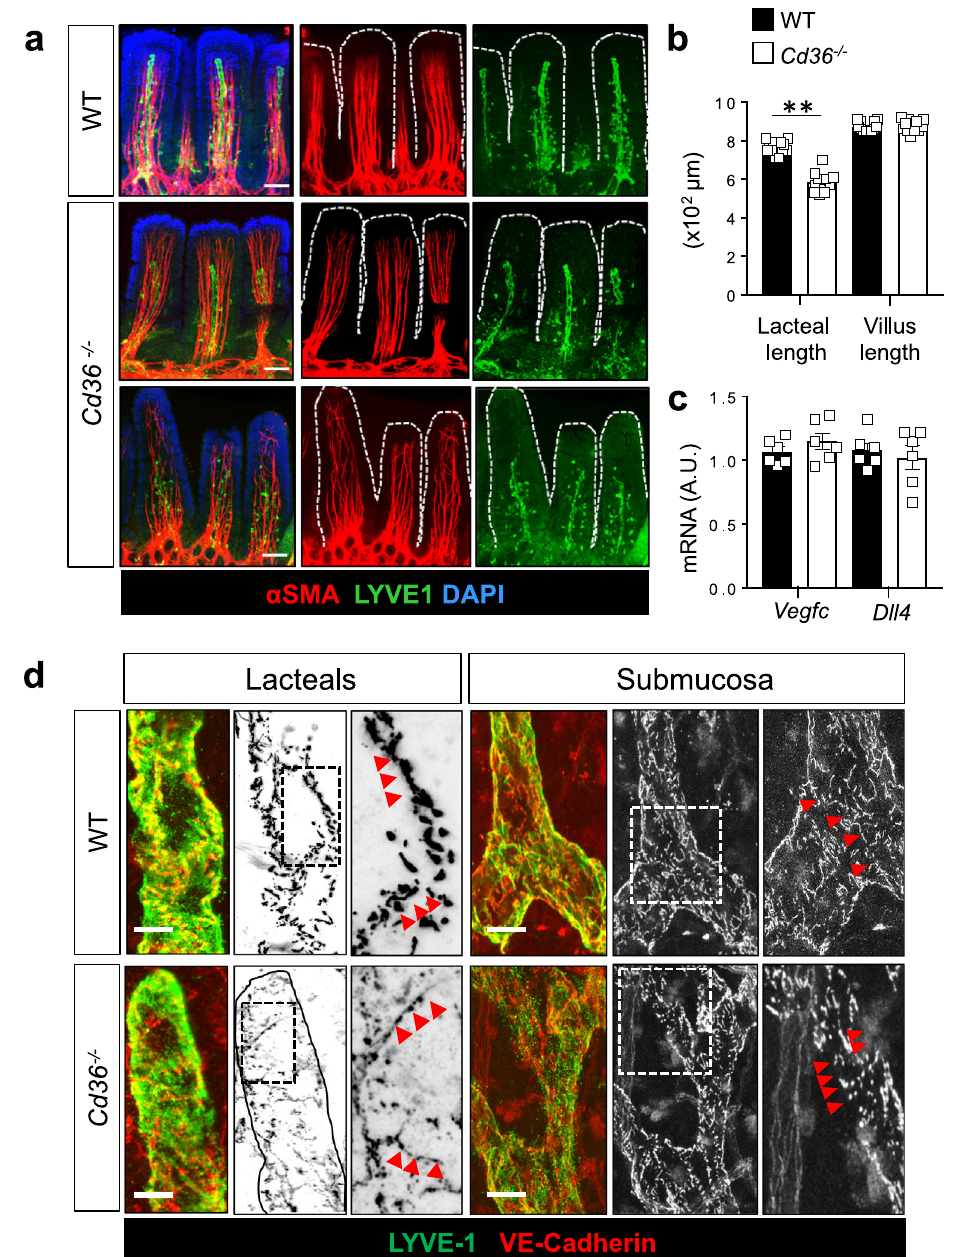
Fig. 2 Cd36 − / − mice have shorter lacteals and disorganized VE-cadherin junctions. a Representative whole-mount staining for lymphatic vessel endothelial hyaluronan receptor 1, LYVE-1, and smooth muscle actin-alpha, α SMA, showing lacteals in jejunum of wild-type (WT) and Cd36 − / − mice. Images were acquired using a Zeiss LSM 880 Airyscan Confocal Microscope, ×20 objective. Scale bar: 50 μ m. b Lacteal and villus length quanti fi ed using ImageJ v1.53i software. Cd36 − / − mice lacteal length is reduced as compared to WT ( P < 0.01) c mRNA expression of vascular endothelial growth factor C, Vegfc , and of delta-like ligand 4, Dll4 , in jejunum of WT and Cd36 − / − mice. d Immunohistochemical analysis performed in whole-mount jejunum stained for vascular endothelial (VE)-cadherin (red) and LYVE-1 (green) showing disorganized VE-cadherin junctions in Cd36 − / − lacteal and in collecting lymphatic vessels as compared with WT mice. Images were acquired using a Zeiss LSM 880 Airyscan Confocal microscope, ×63 objective. Scale bar is 5 μ m. Mice ( n = 6, representative of two independent experiments) used in ( a – b ) are 12-week old. All data are means± SE with n representing the number of mice per group. A.U. arbitrary units. Statistical signi fi cance is determined by two-tailed Student t test. ** P < ~7-fold increase in Tgfb1 and Emr1 gene expression (all P < ( Tgfb1 ) was also similar. However, the expression of genes 0.001) (Fig. 3g). These data suggested that in fl ammation of encoding for pro-in fl ammatory cytokine Tnf , tumor necrosis visceral fat precedes the increase in lipid storage genes, the factor alpha, and the macrophage marker EGF module- expansion of the tissue and the onset of glucose intolerance. We containing mucin-like receptor 1 ( Emr1 ) were increased ( P < evaluated energy expenditure in 11- and 20-week-old Cd36 Δ LEC 0.05 and P < 0.05, respectively) as compared with age-matched mice and their respective controls. The 11-week-old Cd36 Δ LEC control mice (Fig. 3g). At 20 weeks, Cd36 Δ LEC mice showed ~3-fold increases in LpL , Pparg , Tnf, and Il6 gene expression and mice showed decreased VCO 2 (dark and light periods) (Fig. 4a),